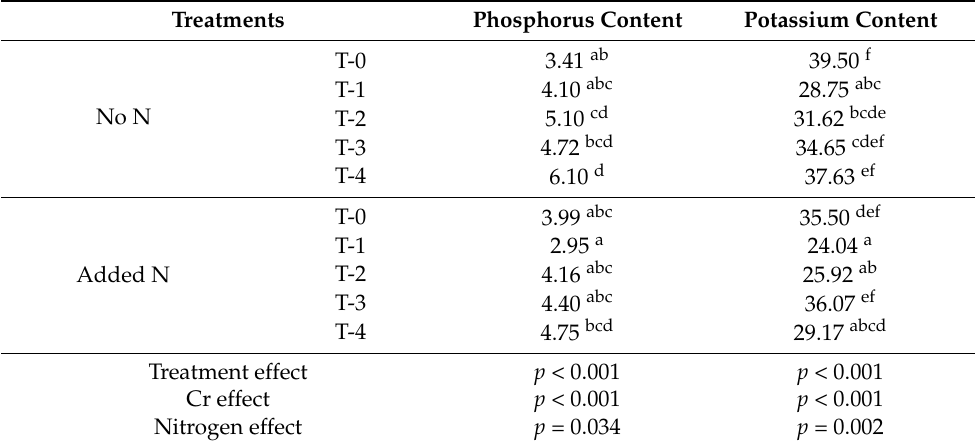
Table 4. Phosphorus and potassium content (g kg − 1 DW) in the aerial part of purslane ( Portulaca oleracea ) aerial tissues (n =